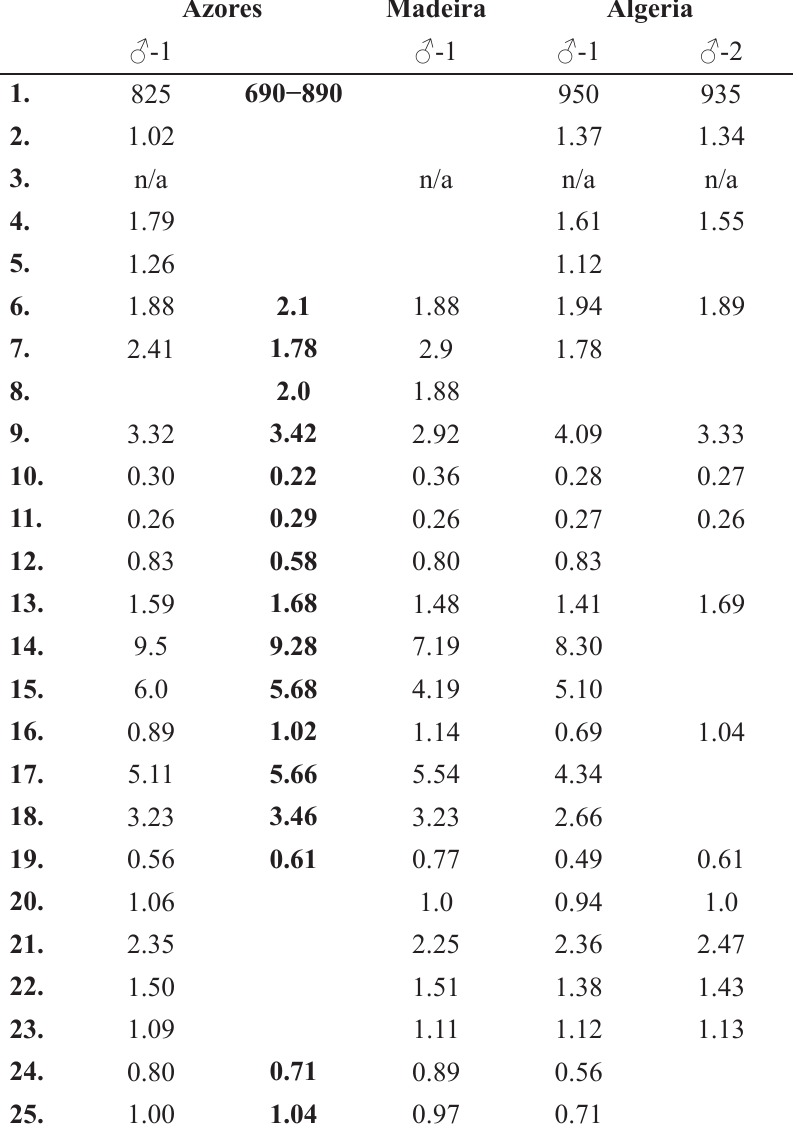
Table 3. Morphometric characters of the male in Eucyclops azorensis Defaye & Dussart, 1991. Data in bold are from the original description of the species: with the exception of the total body length, all indices were measured on the drawings provided by Defaye & Dussart (1991). n/a = non